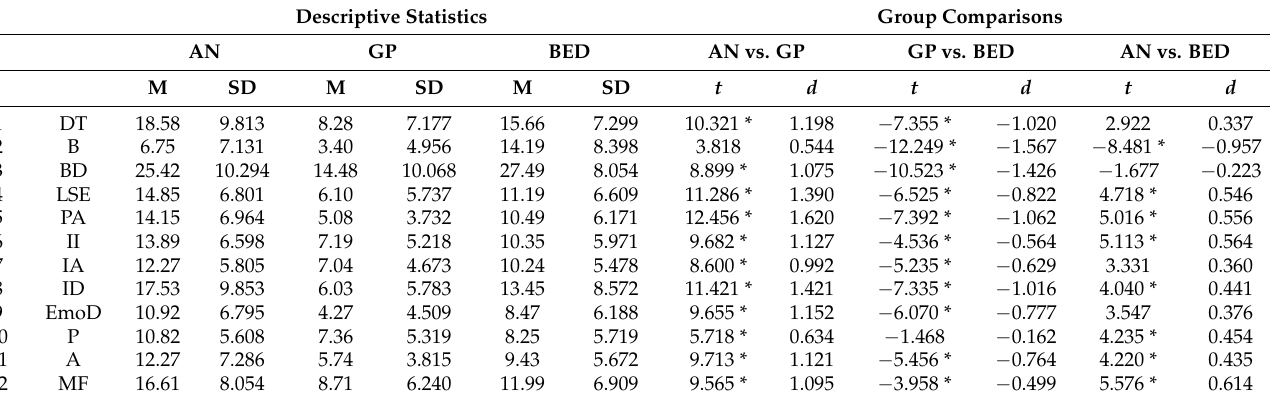
Table 2. Between-groups